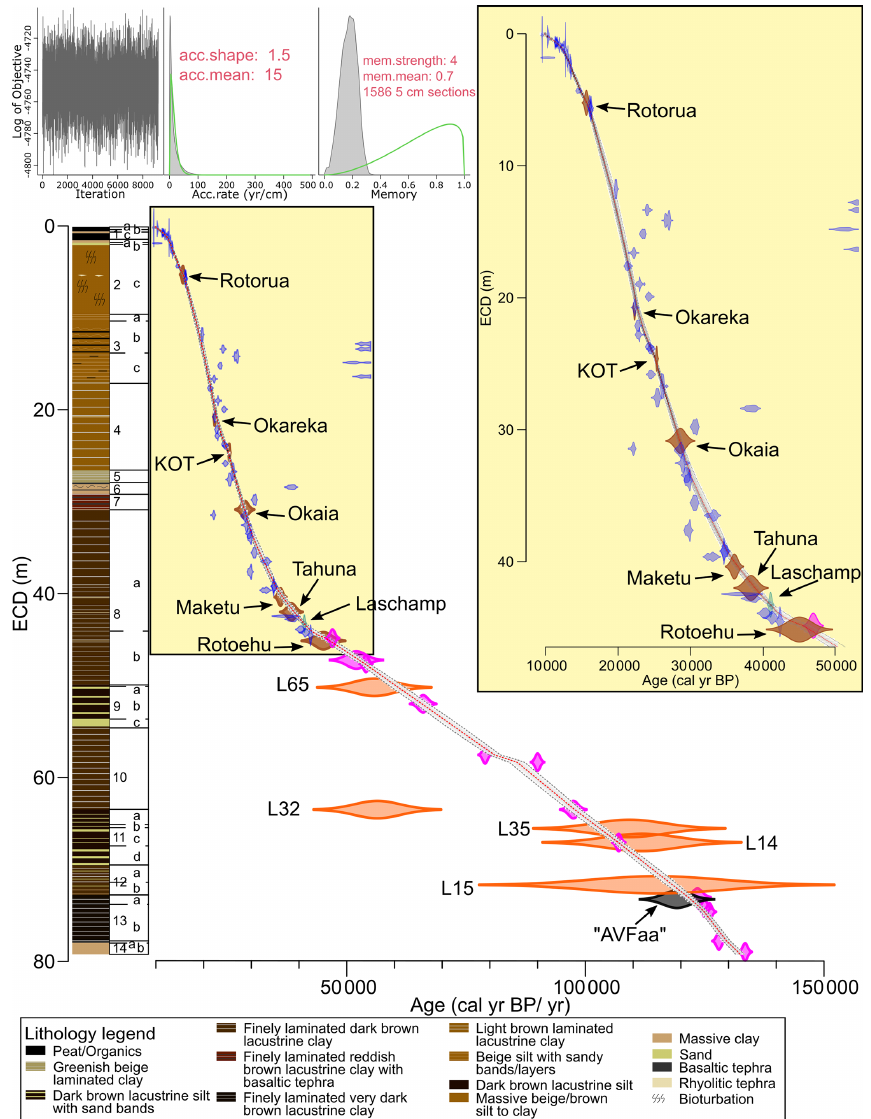
Figure 10. Orakei age model spanning the entire sediment sequence using the event-corrected depth obtained by Bacon age modelling. Dot- ted red line marks the mean age model; dotted grey lines mark the 95% confidence limits. Inset enlarges the interval of ca. 45000calyearsBP. Blue symbols mark calibrated radiocarbon ages, brown symbols mark rhyolitic tephra ages (marked by name), green symbol marks the age of the Laschamp excursion, orange symbols mark luminescence ages (marked by sample codes), pink symbols mark tuning points from DTW alignment of Orakei RPI to PISO-1500 VADM, and the black symbol marks the age of the basaltic “AVFaa” tephra identified as sourced from the Mt Albert volcano. Lithology and facies units from Peti and Augustinus